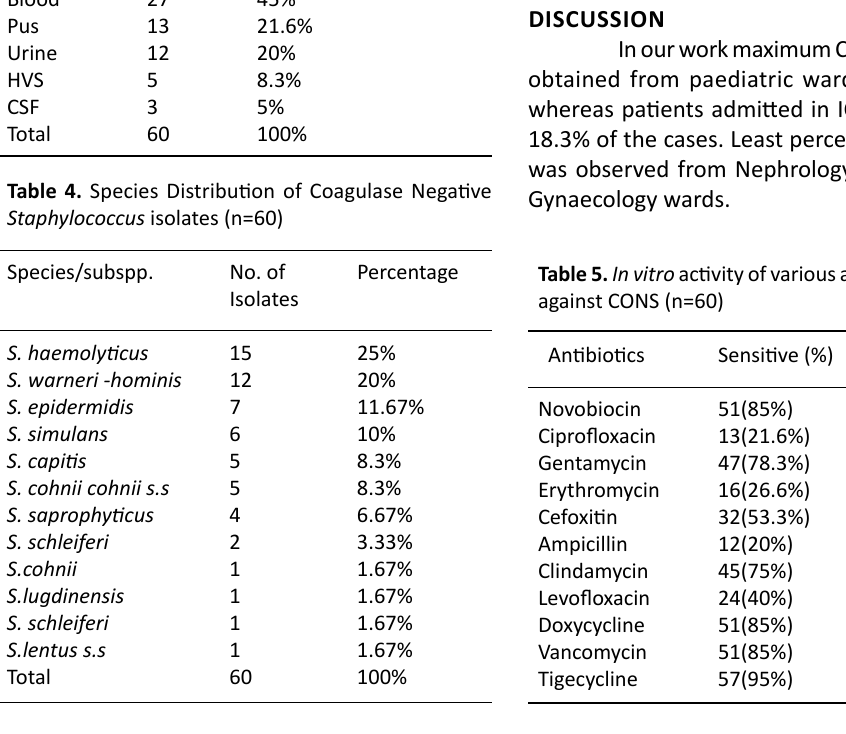
Table 6. Clinical specimens showing isolation rates and Methicillin resistance pattern (n=60) Specimen No.